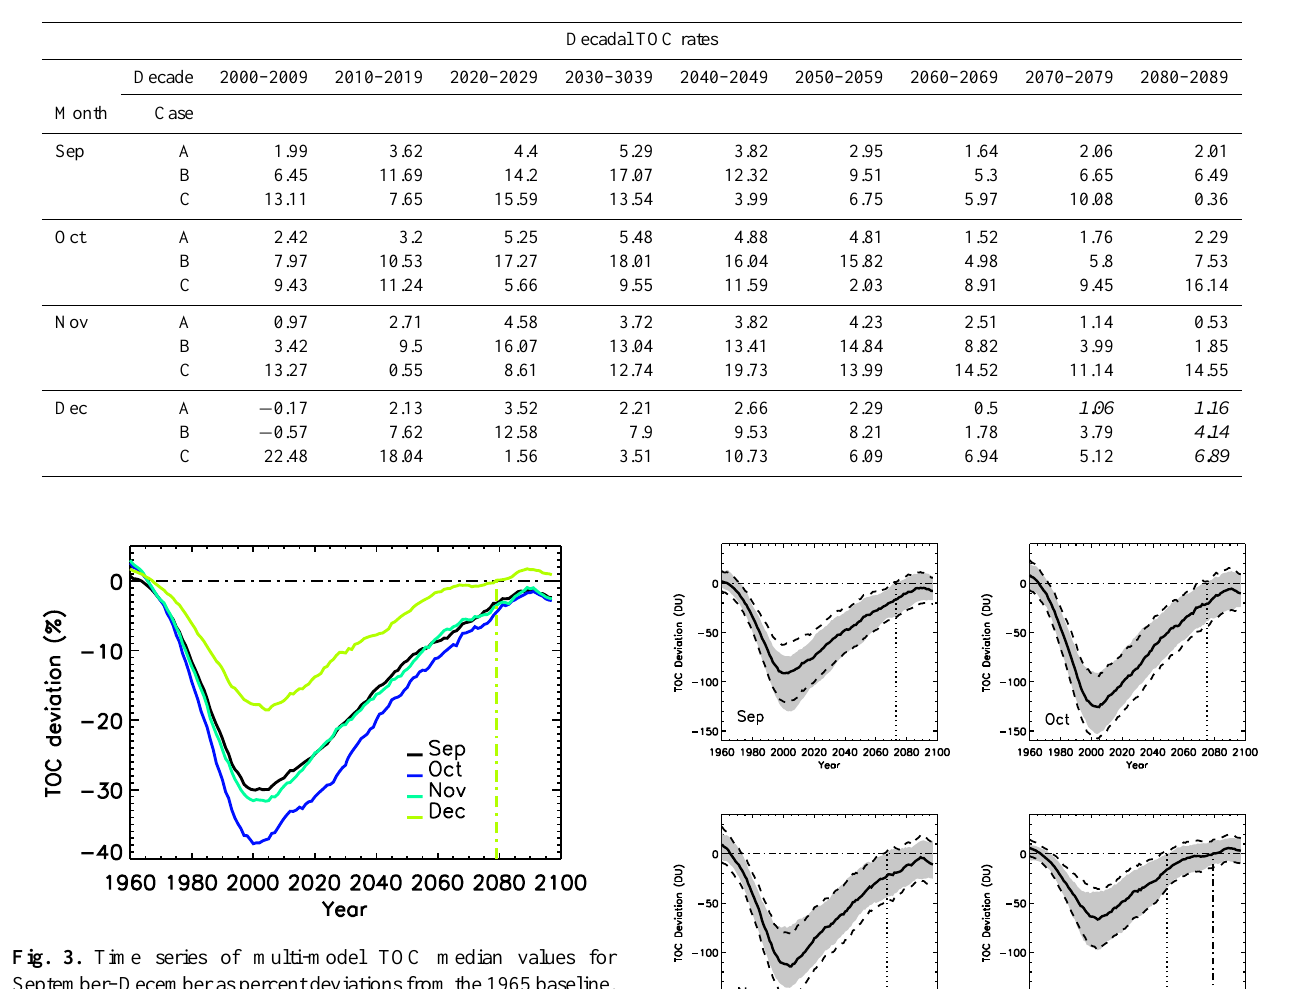
Table 1. Decadal rates and speeds of TOC increase poleward of 60 ◦ S as a percentage of 1965 baseline (Case A), in DU/decade (Case B), and as a percentage relative to maximum depletion (baseline minus ∼ year 2000 conditions) (Case C). Italicized numbers indicate decades when December TOC has exceeded its 1965 baseline value.